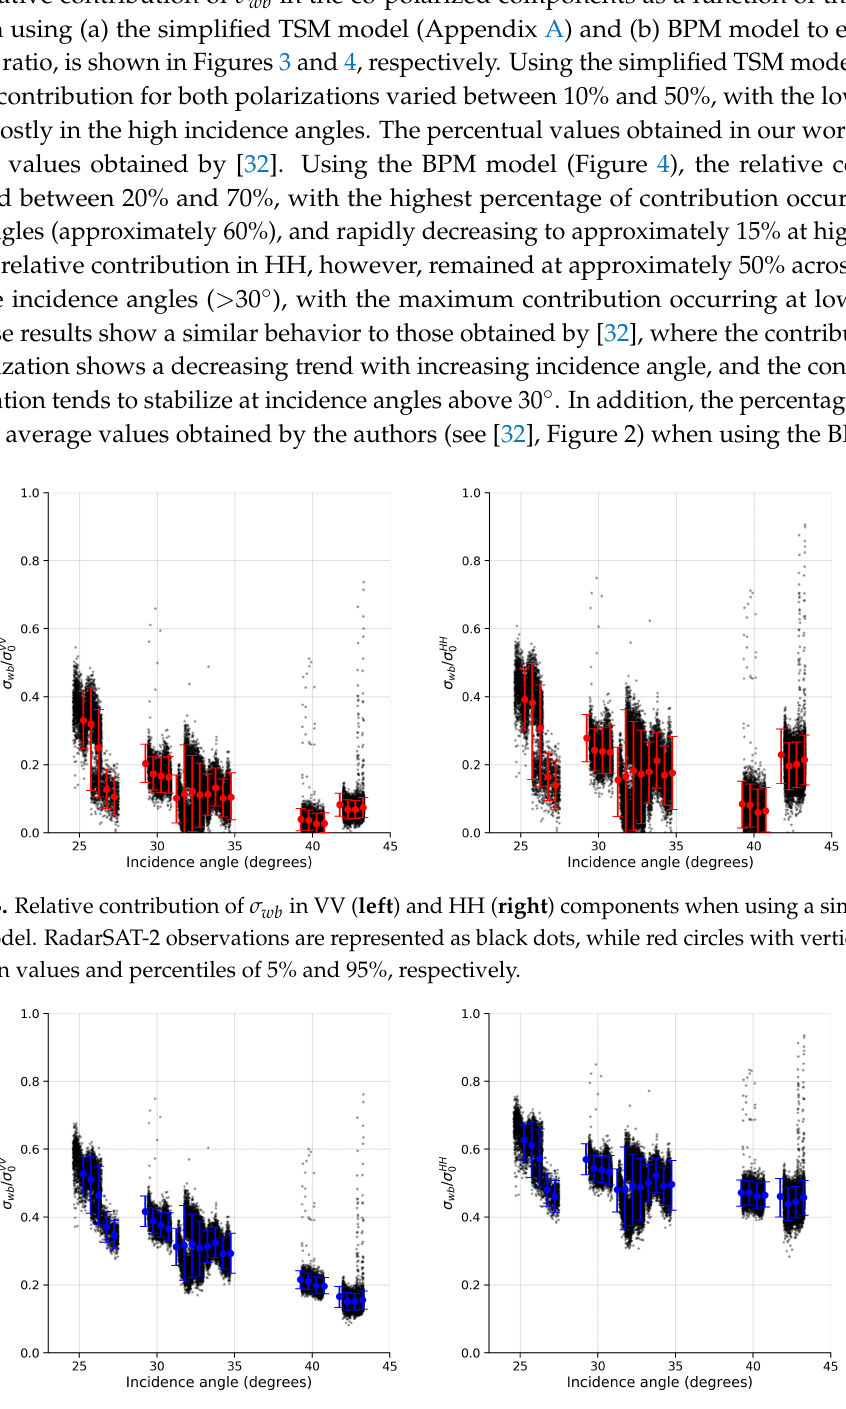
Figure 4. Relative contribution of σ wb in VV ( left ) and HH ( right ) components when using a BPM model. RadarSAT-2 observations are represented as black dots, while blue circles with vertical bars are mean values and percentiles of 5% and 95%,